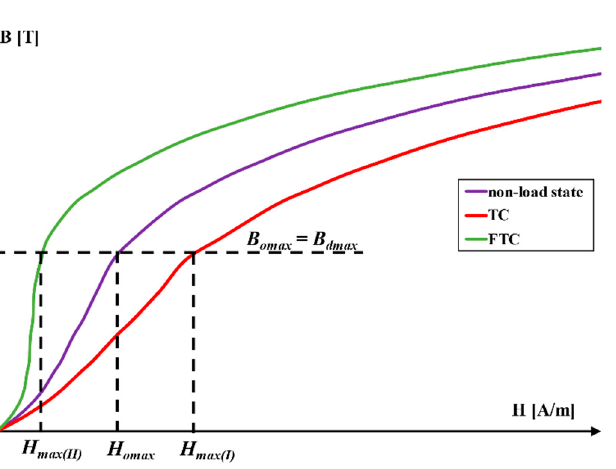
Figure 4. Magnetization curves of the inductive CT (TC—single turn correction, FTC—fractional turn correction).